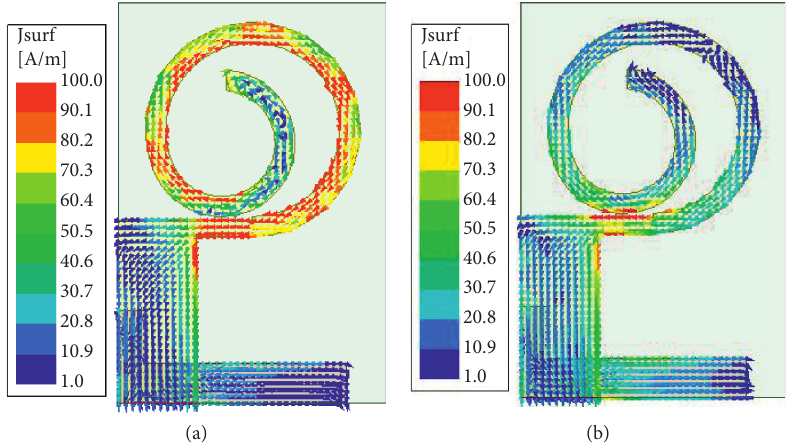
Figure 10: Vector current distribution of the proposed ram horn-like folded antenna: (a) 2.3GHz and (b) 5.8